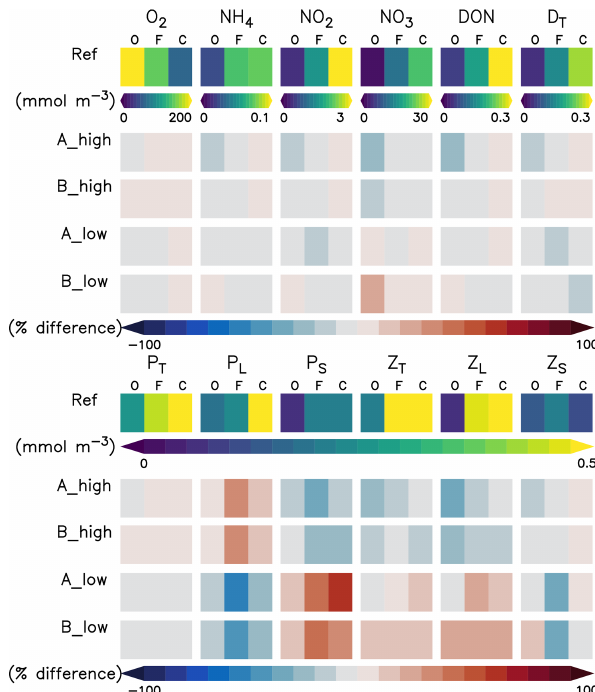
Figure 4. Annually, spatially (oligotrophic (O) region, full domain (F) and coastal upwelling (C) region; see Fig. 1 for further refer- ence) and depth-averaged (0–100m) concentrations (mmolNm − 3 or mmolO 2 m − 3 ) of the biogeochemical prognostic variables in the model reference scenario and normalised percent difference be- tween the reference scenario and experiments. P is phytoplankton; Z is zooplankton; D is detritus; DON is dissolved inorganic nitro- gen; T is total; L is large; S is